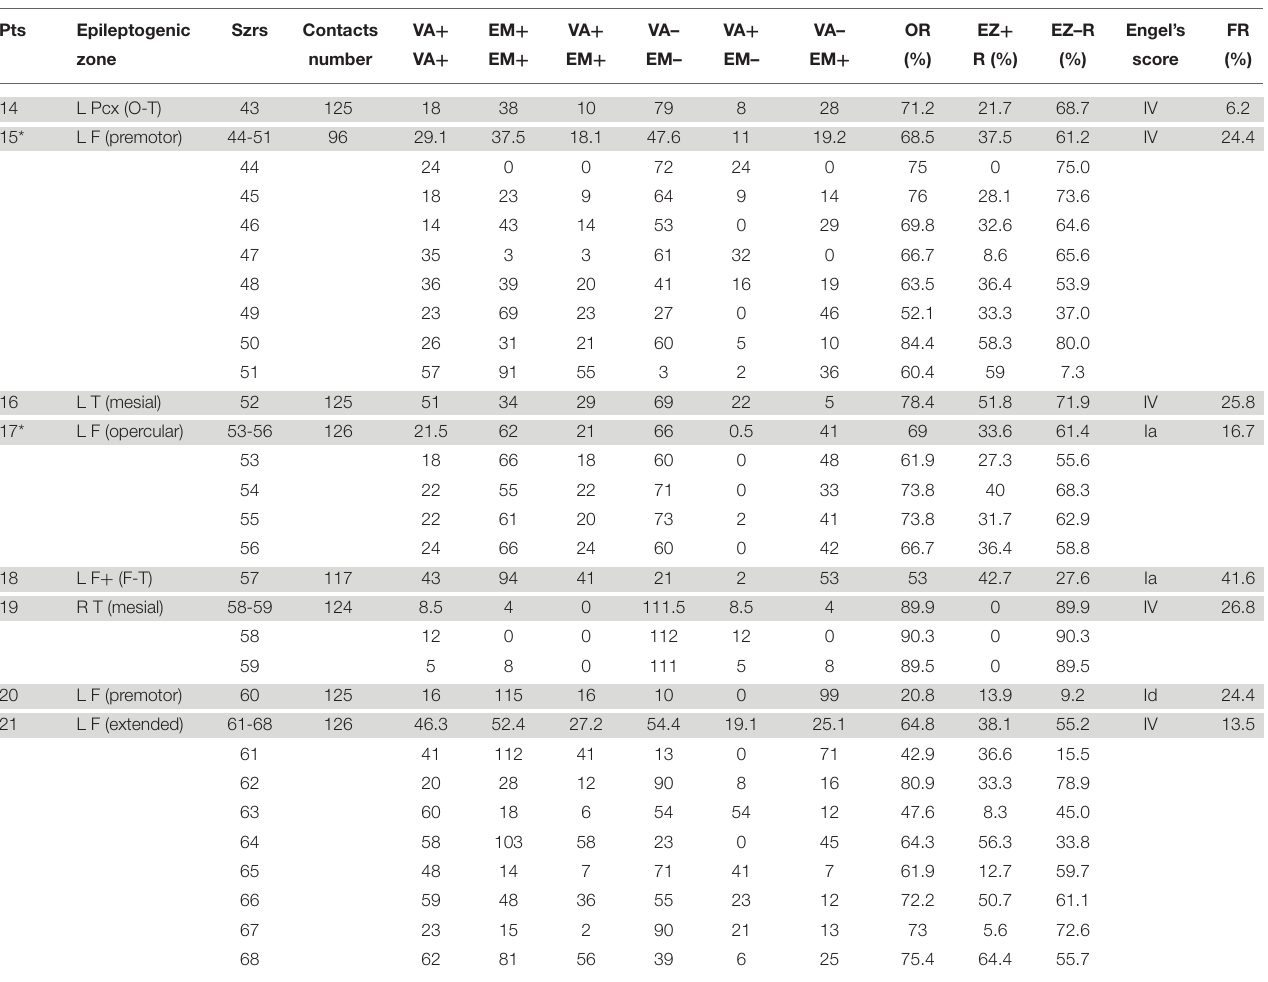
(premotor: 3; opercular: 4; extended: 2) or frontal + (fronto- temporal: 1; fronto-insular: 1) in 11 patients, temporal (mesio- temporal: 4) or temporal + (temporo-insular: 3) in 7 patients, and posterior in 3 patients (occipital: 1, occipito-temporal: